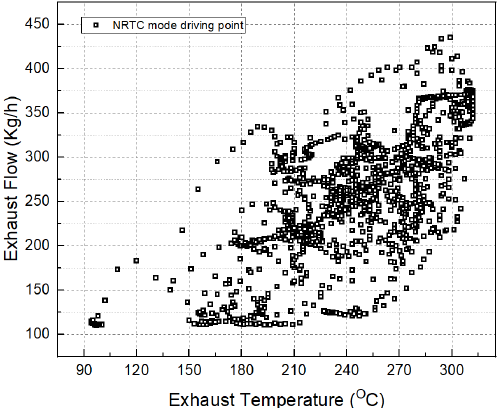
Figure 4. Real-time data (speed, torque, and temperature) of the non-road transient cycle (NRTC) mode.